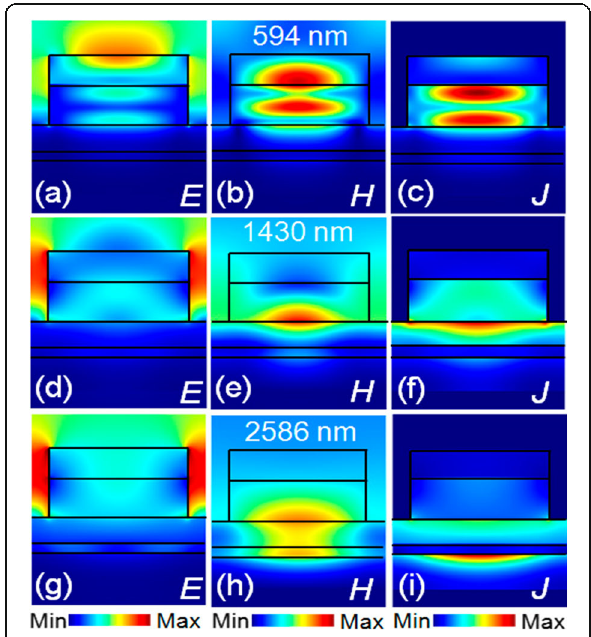
Fig. 2 Electric field | E |, magnetic field | H | distributions, and current density J at 594 nm ( a – c ), 1430 nm ( b – f ), and 2586 nm ( g – i ),